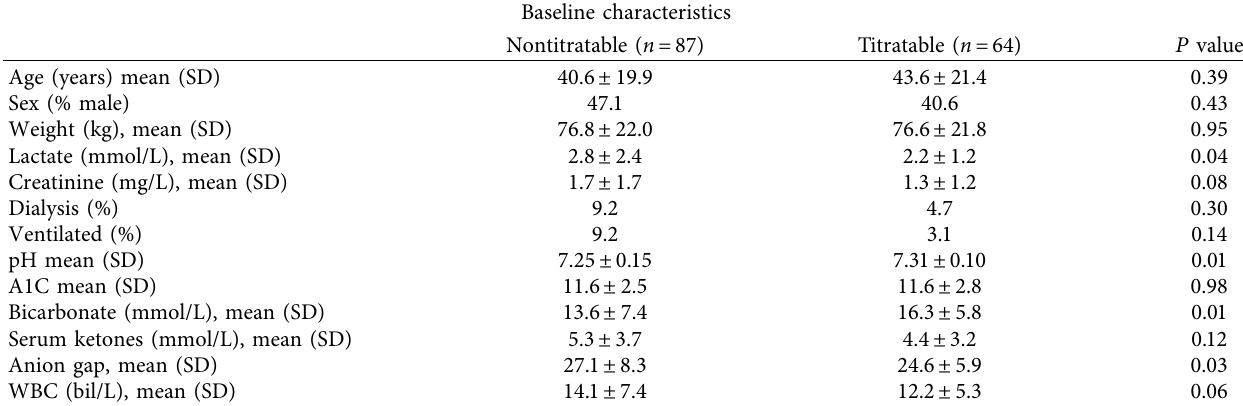
Table 1: Titratable vs. nontitratable insulin infusion patients.